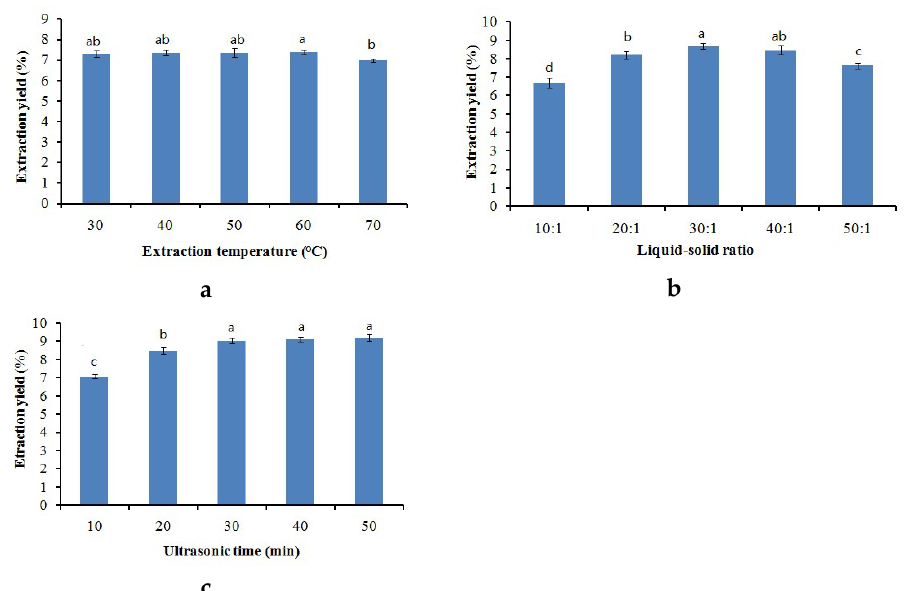
Figure 2. Extraction yields of ionic liquid based ultrasonic assisted extraction (IL-UAE) affected by ( a ) extraction temperature; ( b ) liquid-solid ratio; and ( c ) ultrasonic time. Different letters in the same series indicate significant difference at p < 0.05.